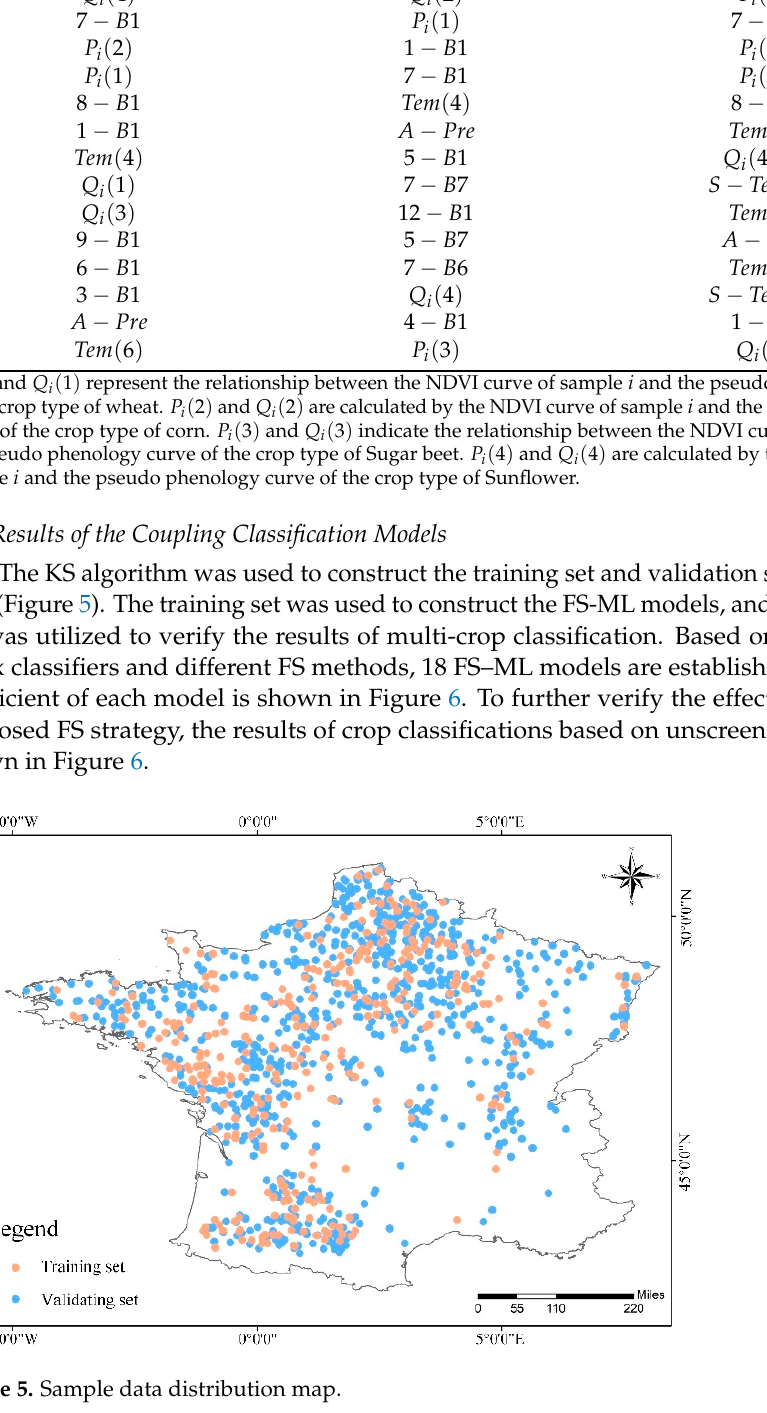
Figure 6. The kappa coefficients of coupling models for multiple crop classification. RF = random forest; SVM = support vector machine; KNN = K-nearest neighbor classification; NB = naïve bayes; ANN = artificial neural network; XGBoost = Extreme Gradient Boost; 1D-CNN = one-dimensional convolutional neural network; RFAA+ = improved average accuracy reduction; RFAI+ = improved random forest average impurity; RFE = recursive feature elimination. Figure 7 shows that, in terms of a single crop, the classification effect of wheat in RFAA+-RF is high, with an F1-score ≈ 0.84, whereas, in other models, the F1-scores are mostly below 0.8. For corn, RFAA+-RF performs optimally with an F1-score ≈ 0.84 and an accuracy ≈ 0.91, whereas the classification effect of other FS–ML model s are mostly poor, with an F1-score below 0.9. For sugar beet , RFAI+-SVM can successfully recognize this crop type with an F1-score ≈ 1, while RFAA+-RF can also achieve high-precision identifi- cation of these crop types with an F1-score ≈ 0.91. For sunflower, RFAA+-RF performs optimally with an F1-score ≈ 0.87, which is the most effective FS–ML model for these crop types. In summary, the RFAA+-RF model based on the fusion indexes of spectral, textural, and environmental indexes has a relatively satisfactory classification effect in the study area.